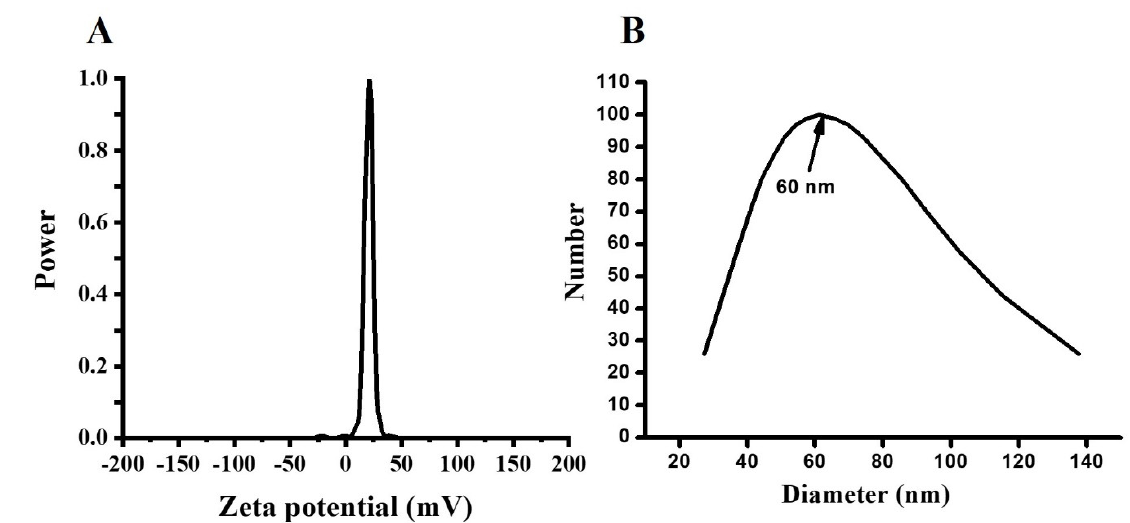
Figure 3. Zeta potential measurement of Encap. MOLE NPs ( A ). Nanosizer of Encap. MOLE NPs ( B ).